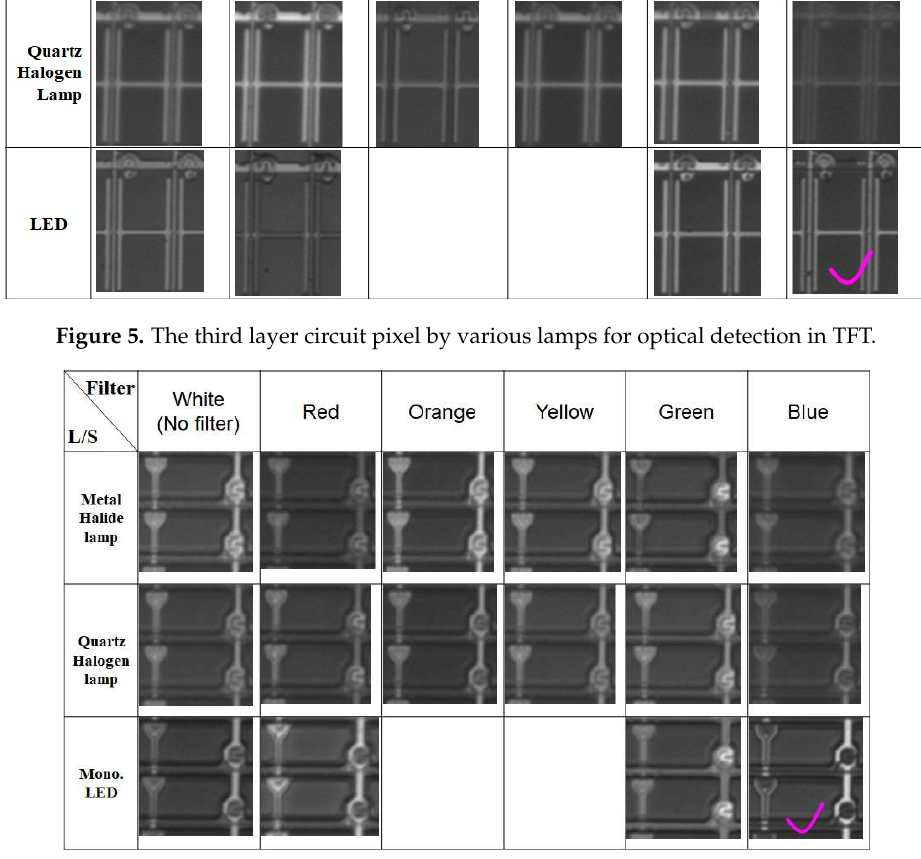
Figure 5. The third layer circuit pixel by various lamps for optical detection in TFT.